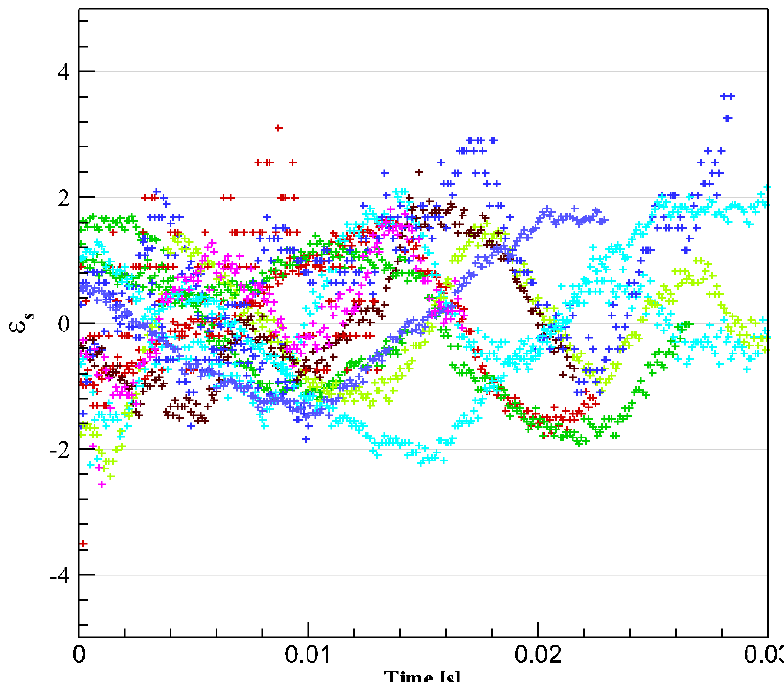
Figure 9. Standardization, (cid:101) S , is shown over time for several marked bubbles at V ∞ = 3 m/s, Q = 5 SLPM